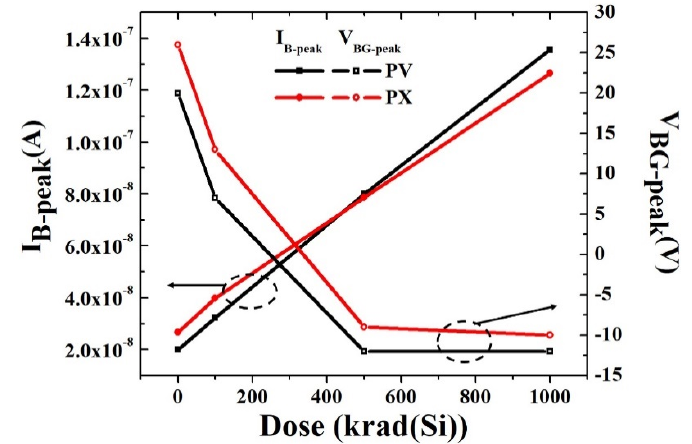
Figure 6. The experimental peak current I B-peak and peak voltage V BG-peak as functions of radiation dose in the devices with a high-voltage well (PX) process (red line) and a low-voltage well (PV) technology (black line).